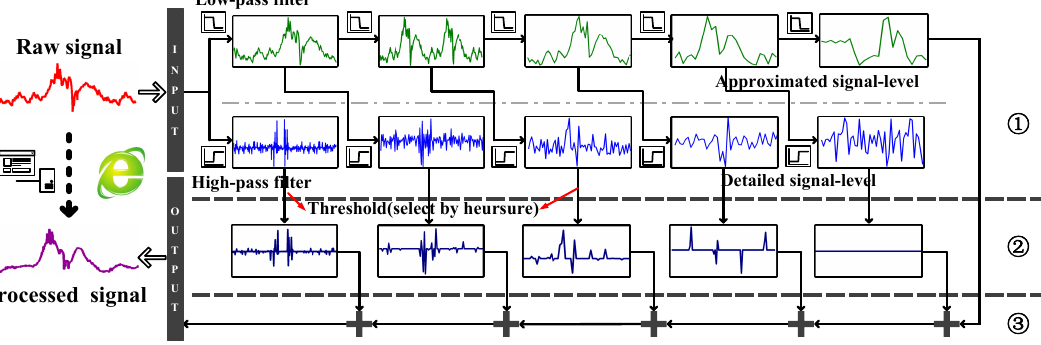
Figure 6. Noise reduction using DWT ( 1 (cid:13) decomposition; 2 (cid:13) threshold denoising; 3 (cid:13)